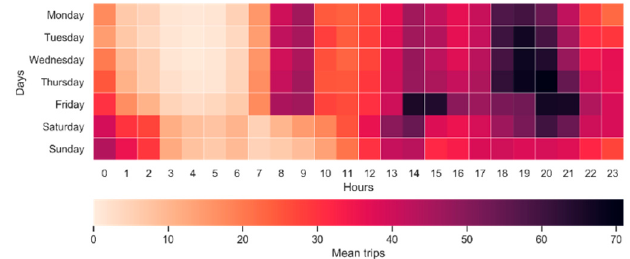
Figure 2. Average trips by day of the week and